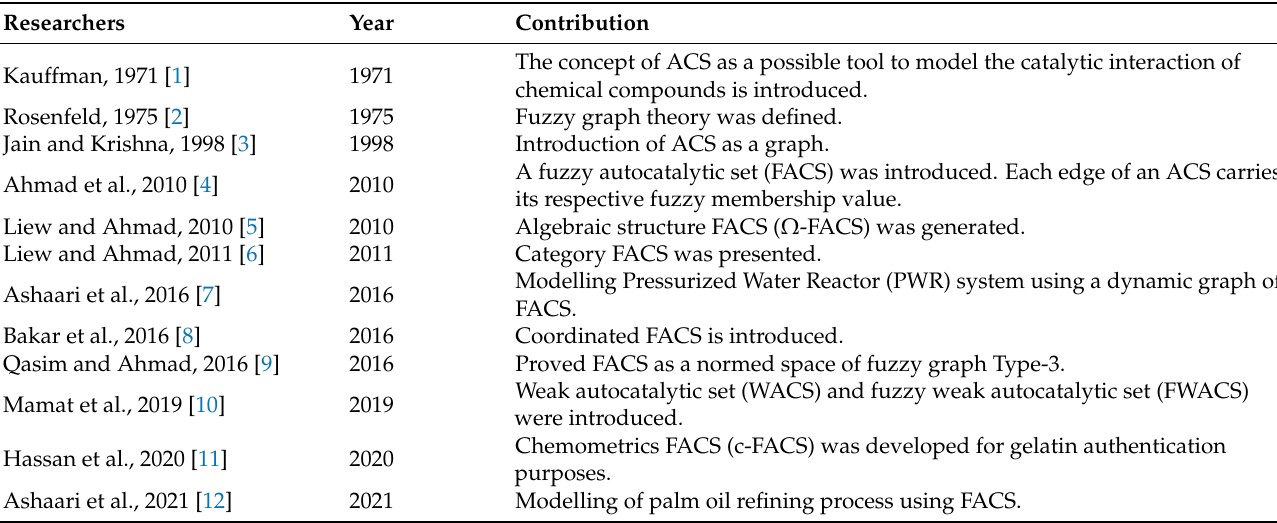
Table 1. Development of autocatalytic set theory.